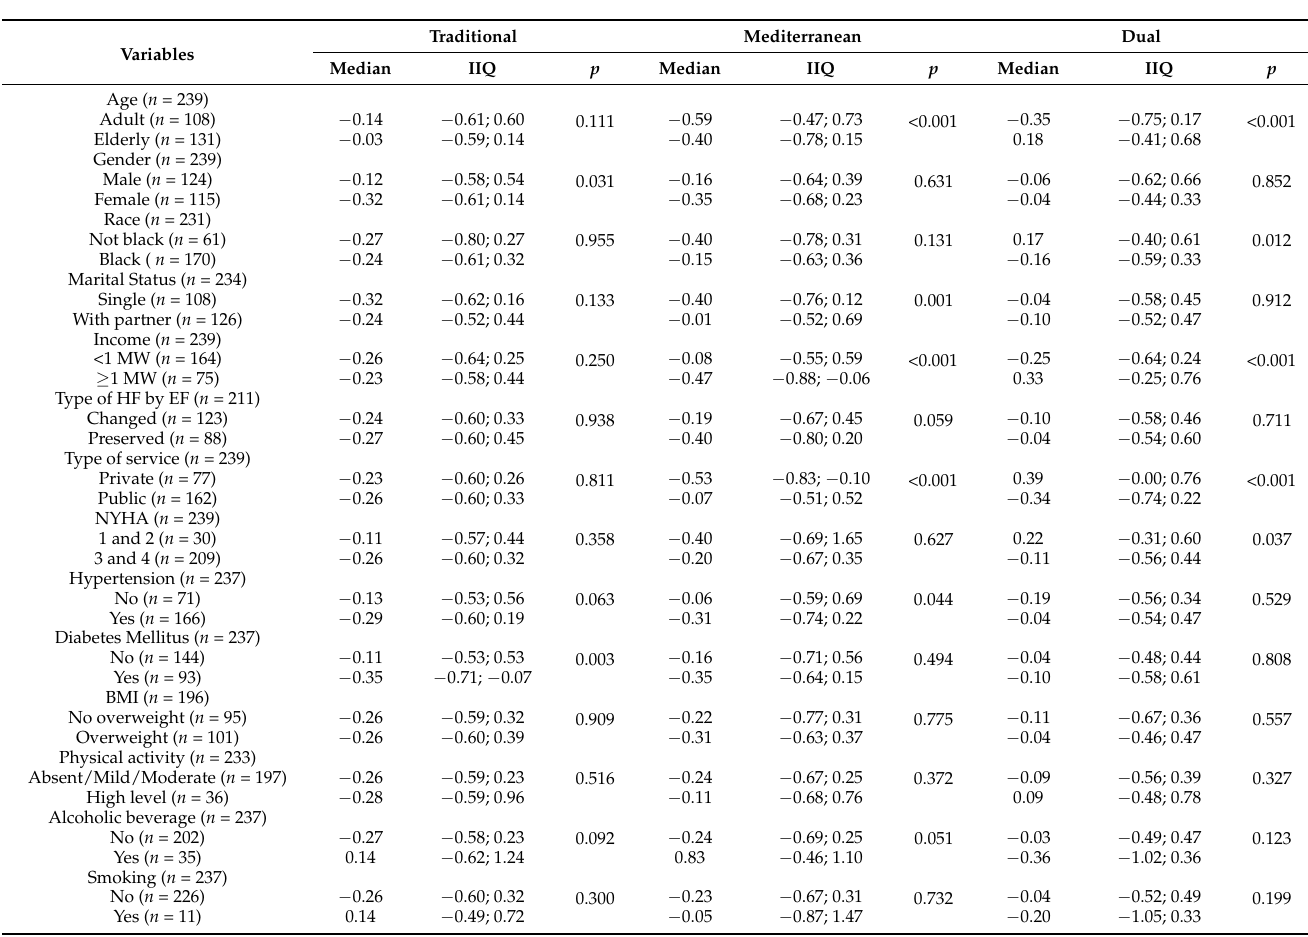
Table 4. Factor scores of dietary patterns according to sociodemographic, clinical, lifestyle and nutritional characteristics of patients hospitalized with HF in Aracaju, SE, 2021.